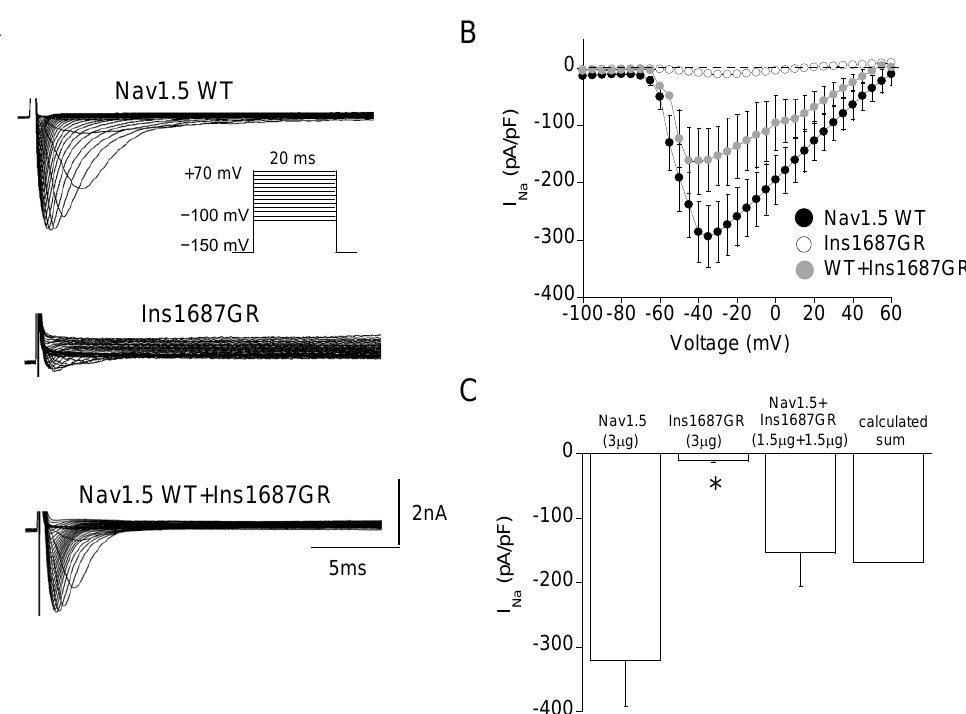
Figure 5. Current density of Nav1.5WT, Ins1687GR, and WT+Ins1687GR channels expressed in HEK 293 cells. ( A ) Repre- sentative sodium current traces from cells transfected with Nav1.5 WT (3 µg), Ins1687GR (3 µg) and Nav1.5+Ins1687GR (1.5 µg +1.5 µg) cDNAs. The voltage protocol is shown in the inset. ( B ) IV plot showing the mean current density of Nav1.5 WT, Ins1687GR and WT+Ins1687GR channels as a function of membrane potential. ( C ) Bar graph showing the mean current density measured at -30mV for the indicated channels. Data are mean ± SE; n = 11–21 cells. * p < 0.05 for Ins1687GR channels compared with Nav1.5 WT.